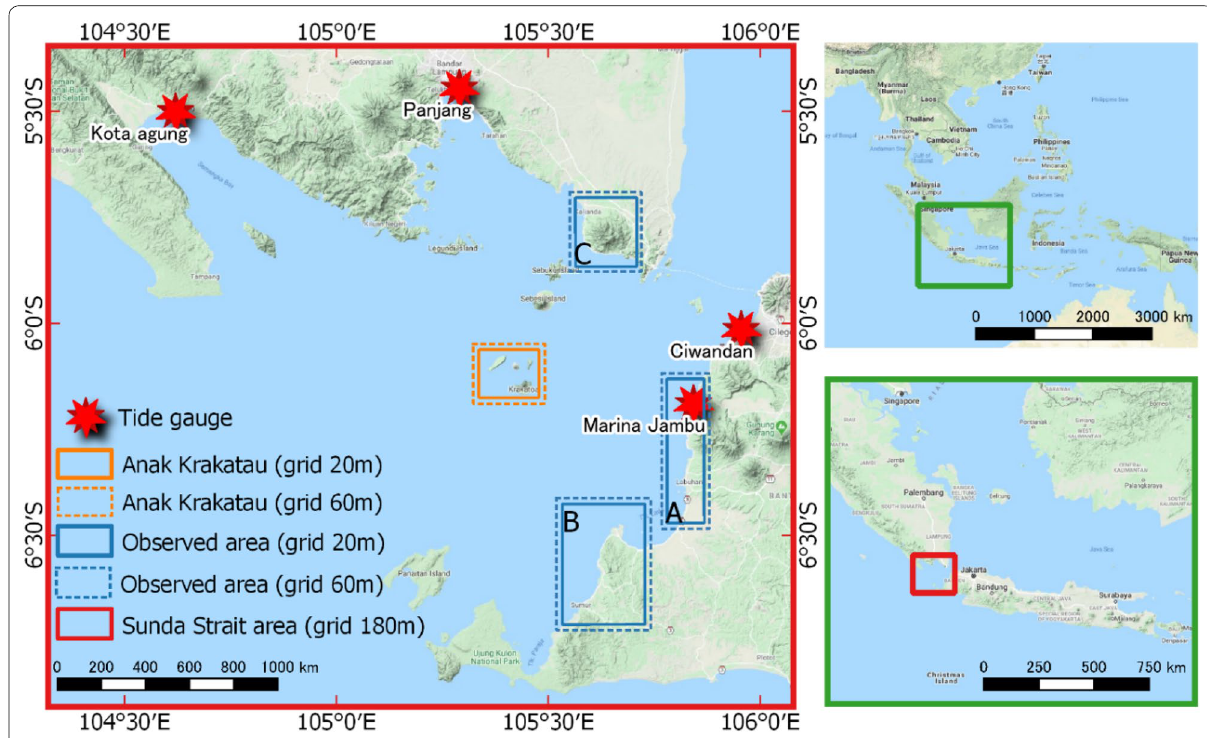
Fig. 1 Computation domain for the tsunami model in the Sunda Strait. The red box represents the main region with a resolution of 180 m and covering the Sunda Strait. For the tsunami runup area model, the transition region with a resolution of 60 m is shown by the blue dashed box , and the observed region with a resolution of 20 m is shown by the blue solid box . The orange box is the location of Anak Krakatau in the middle of the Sunda Strait; the dashed box has a resolution of 60 m, and the solid box has a resolution of 20